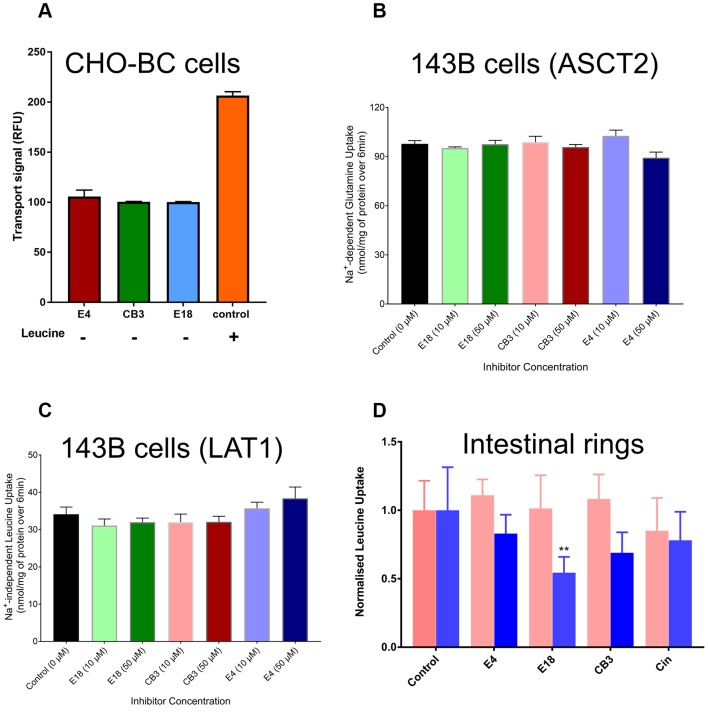
Specificity and efficacy of B0AT1 inhibitors. When tested alone, compounds E4, E18, and CB3 (30 μM, n = 3, e = 2) did not increase fluorescence above the baseline (100 RFU) in the FLIPR assay in CHO-BC cells (A). Although structurally unrelated to the substrates of the transporter, compounds E4, E18, and CB3 are highly specific. They failed to inhibit Na+-dependent glutamine uptake in 143B cells, which is largely mediated by ASCT2 (B) or Na+-independent leucine uptake in 143B cells, which is mediated by LAT1 (C) (n = 3, e = 3). Panel (D) shows the potential of E4, E18, and CB3 (50 μM) to inhibit Na+-dependent (B0AT1, blue bars) and Na+-independent (rbat/b0,+AT salmon coloured bars) uptake of leucine in inverted sections of mouse intestine (n = 3, e = 3); **p < 0.01 as compared to the control.